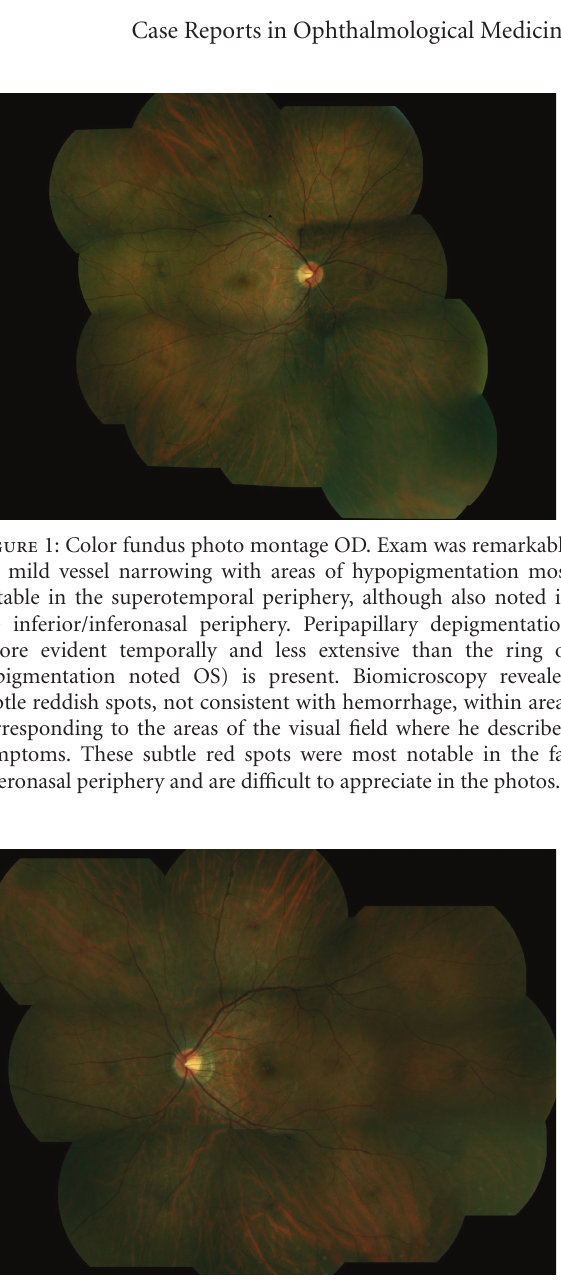
Figure 2: Color fundus photo montage OS. Vessel narrowing with perivenular pigment deposition and surrounding hypopigmenta- tion is noted in the superior periphery. On exam, perivascular pigment deposition was also present in the far inferior periphery (too peripheral to be captured in the photos). Hypopigmentation is also noted in the inferior periphery. A ring of peripapillary depig- mentation is evident. Subtle reddish spots (di ffi cult to appreciate in the photos) were noted on biomicroscopy in the far inferior periphery and far superonasal